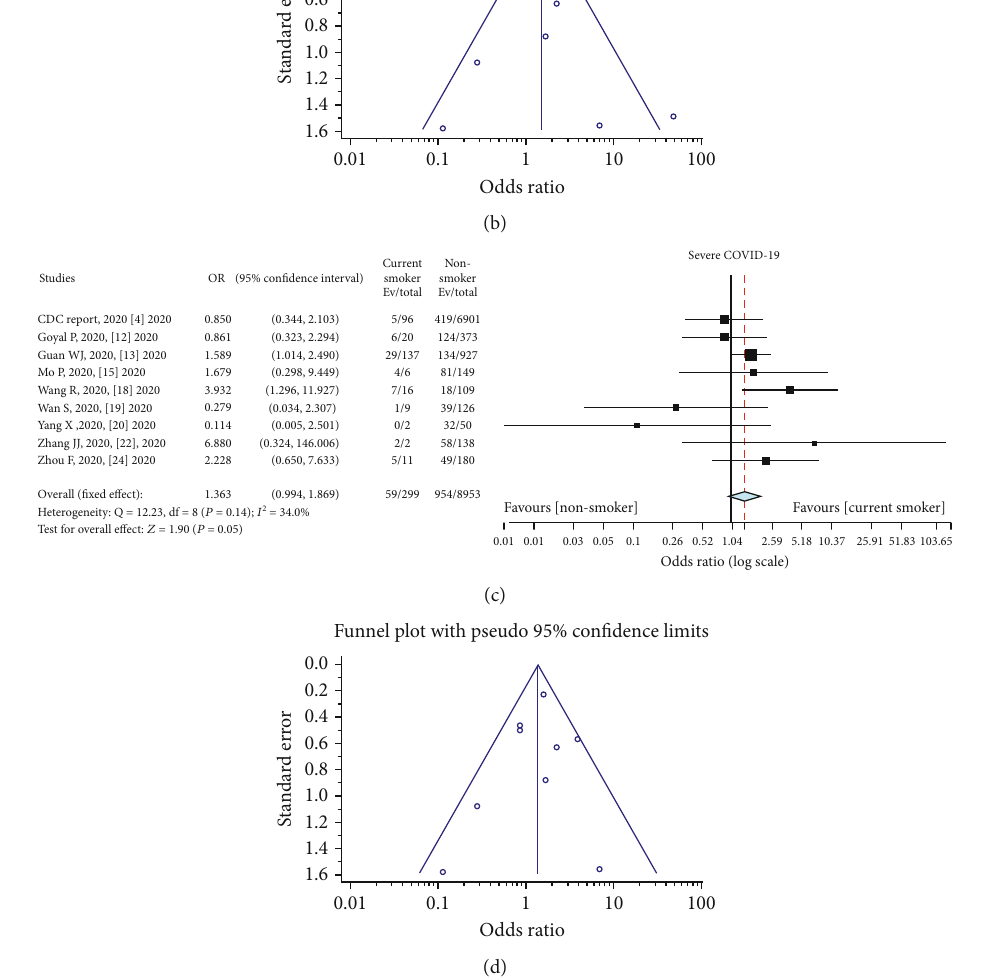
Figure 3: (a) Comparison of smoking status in severe COVID-19 patients. (b) Funnel plot for the meta-analysis of smoking among severe COVID-19 patients. (c) Comparison of smoking status among severe COVID-19 patients after the exclusion of a study by Zhang et al. [23]. (d) Funnel plot for the meta-analysis of smoking among severe COVID-19 patients after the exclusion of a study by Zhang et al.